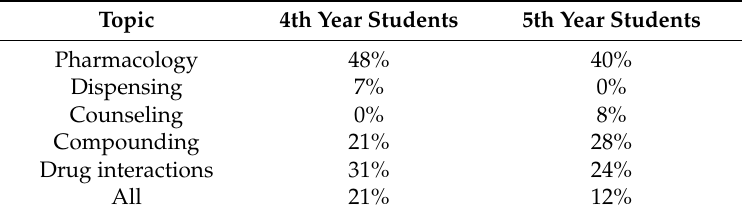
Table 1. Areas identified by veterinary students at Massey University in New Zealand where they would like to learn more about.